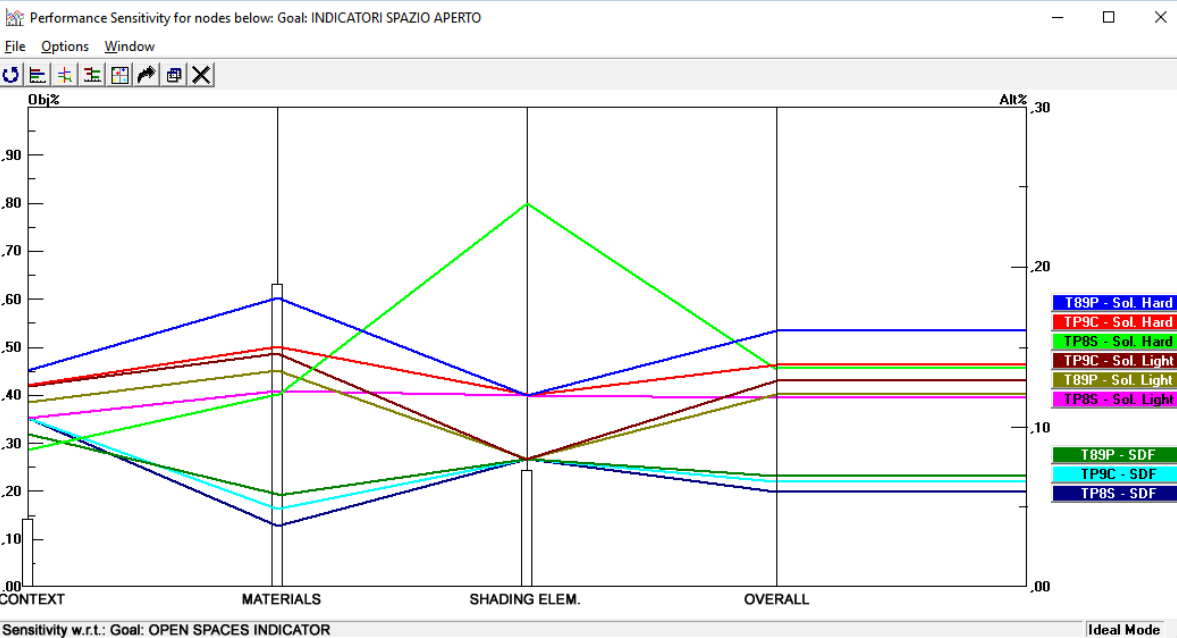
Figure 20. Sensitivity analysis of the performance of meta-design alternatives.